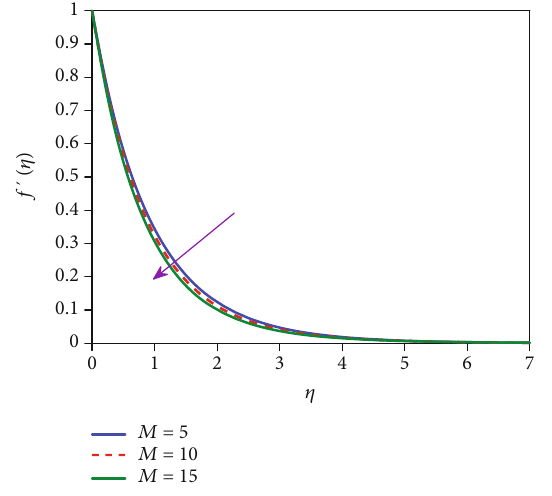
Figure 6: E ff ect of M on the primary velocity f ′ ð η Þ